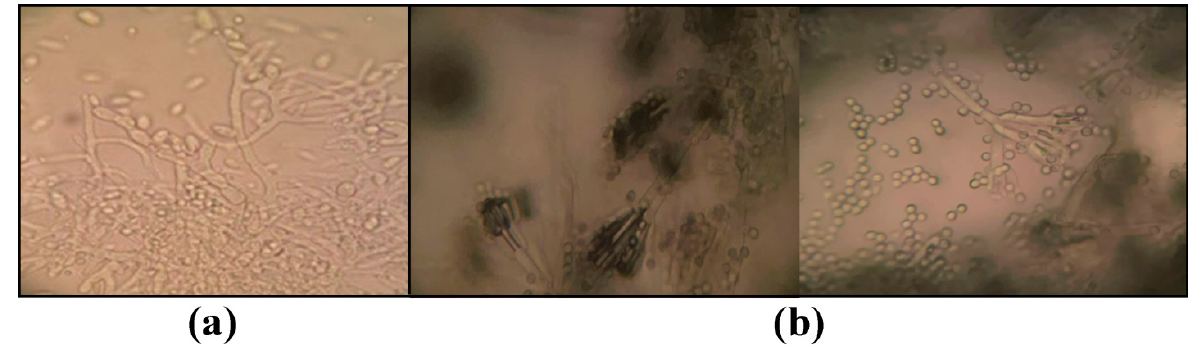
Figure 4. Microscopical aspects sample (( a ) Cladosporium spp.; ( b ) Penicillium spp.).